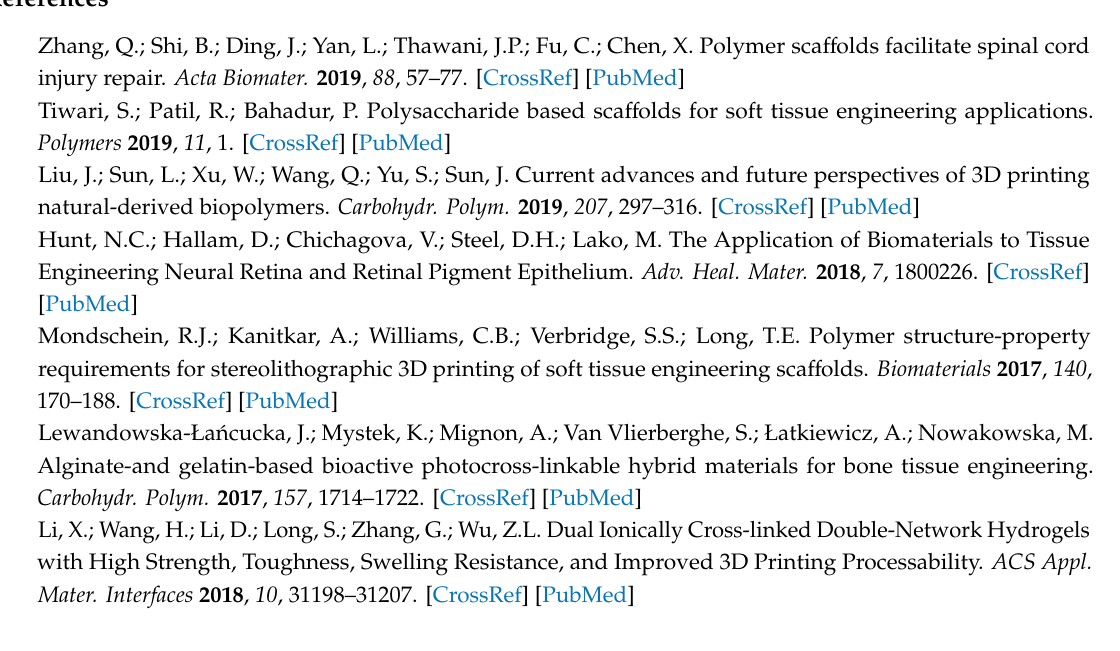
Figure S1: The 1H NMR spectrum of Azo-hydrazide, Figure S2: The rheological property change of alginate solution, Figure S3: The rheological properties of the pre-gel, Figure S4: The pre-gel of Azo-alginate gel merged in ddH2O, Figure S5: The rheological properties of the gel when the molar ratio of linker and alginate carboxyl groups, Figure S6: The rheological property of chemical alginate-based gel, Figure S7: The rheological properties of Azo-alginate gel after being irradiated by 365 nm and 450 nm light for 10 min, Figure S8: The rheological properties of Azo-alginate gel after being irradiated by 365 nm and 450 nm light for 20 min, Figure S9: The G’ and G” of Azo-alginate gel before and after